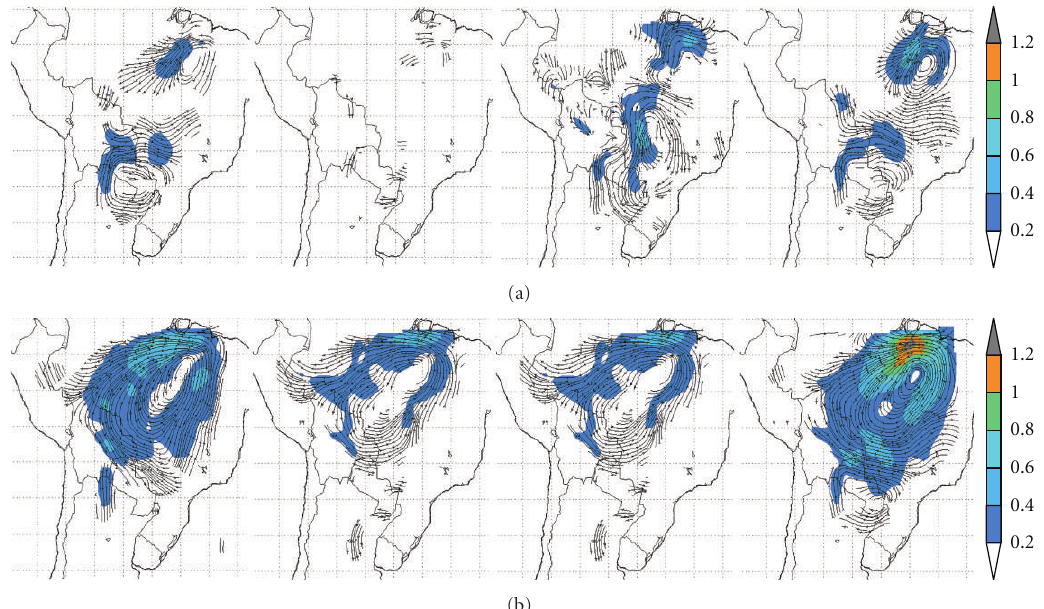
Figure 12: Seasonal 850 hPa wind field di ff erences for ERA-40 driven runs for deforestation/land-use scenarios a) MAP1 and b) MAP2. Starting from the left the columns correspond to summer (DJF), autumn (MAM), winter (JJA) and spring